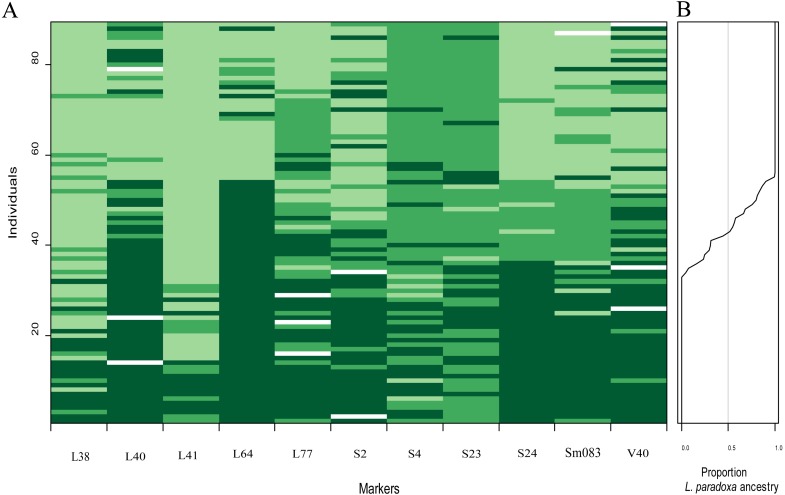
Overview plot of patterns of introgression for all markers and individuals in an admixed population.Markers are ordered based on map locations (A). Each rectangle corresponds to an individual’s genotype at a given locus: dark green, indicating L. duciformis homozygotes (Ad/Ad), to light green indicating L. paradoxa homozygotes (Ap/Ap); heterozygote (Ad/Ap) genotypes are represented by intermediate green blocks. White blocks indicate missing data. (B) is a plot of the fraction the genome inherited from L. paradoxa ancestry.